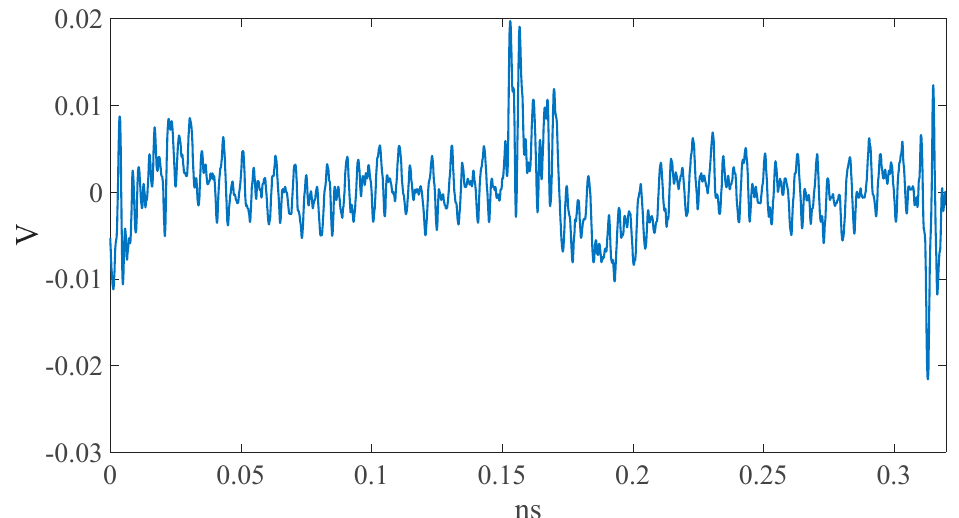
Figure 15. dsPIC33EP512MC202 EM leak.